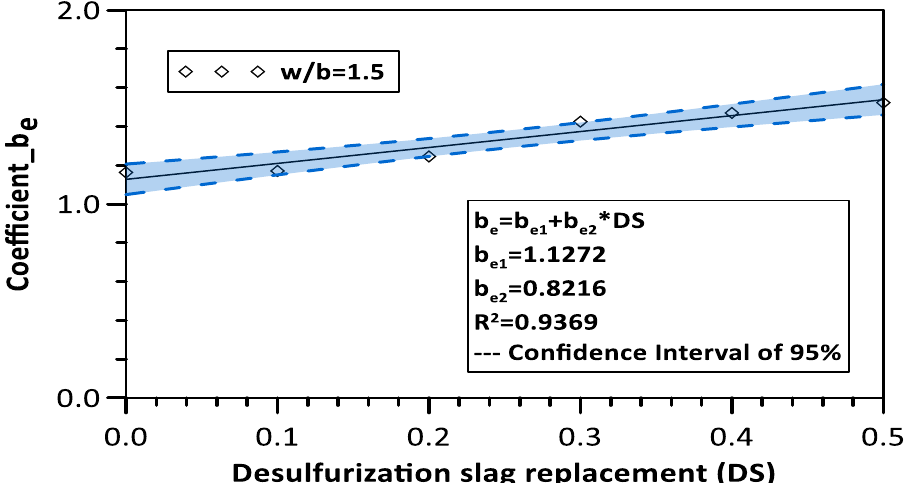
Figure 13. Characteristics of the coefficient 𝑏 𝑒 of the surface resistivity prediction model versus the DS content.